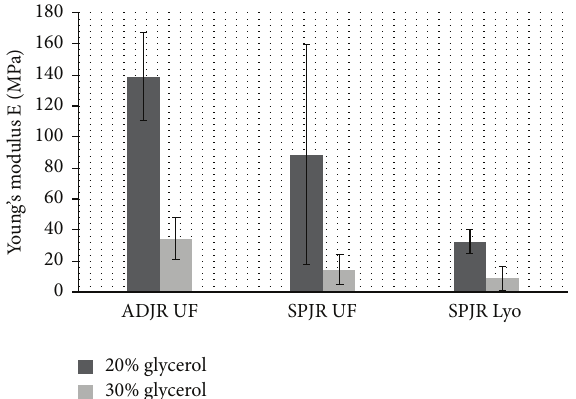
Figure 5: Surface energy values of Jatropha -based cast films. The numbers 20 and 30 indicate the percentage of glycerol added in relation to the dry